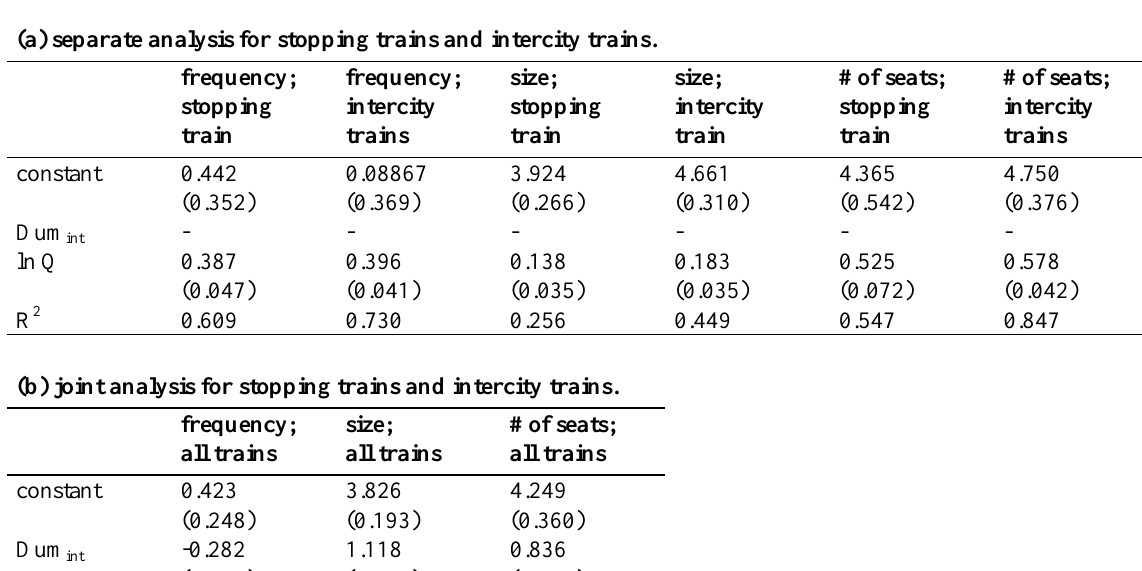
Table 2. OLS estimation results of dependence of service frequency and vehicle size on passenger demand (standard errors in